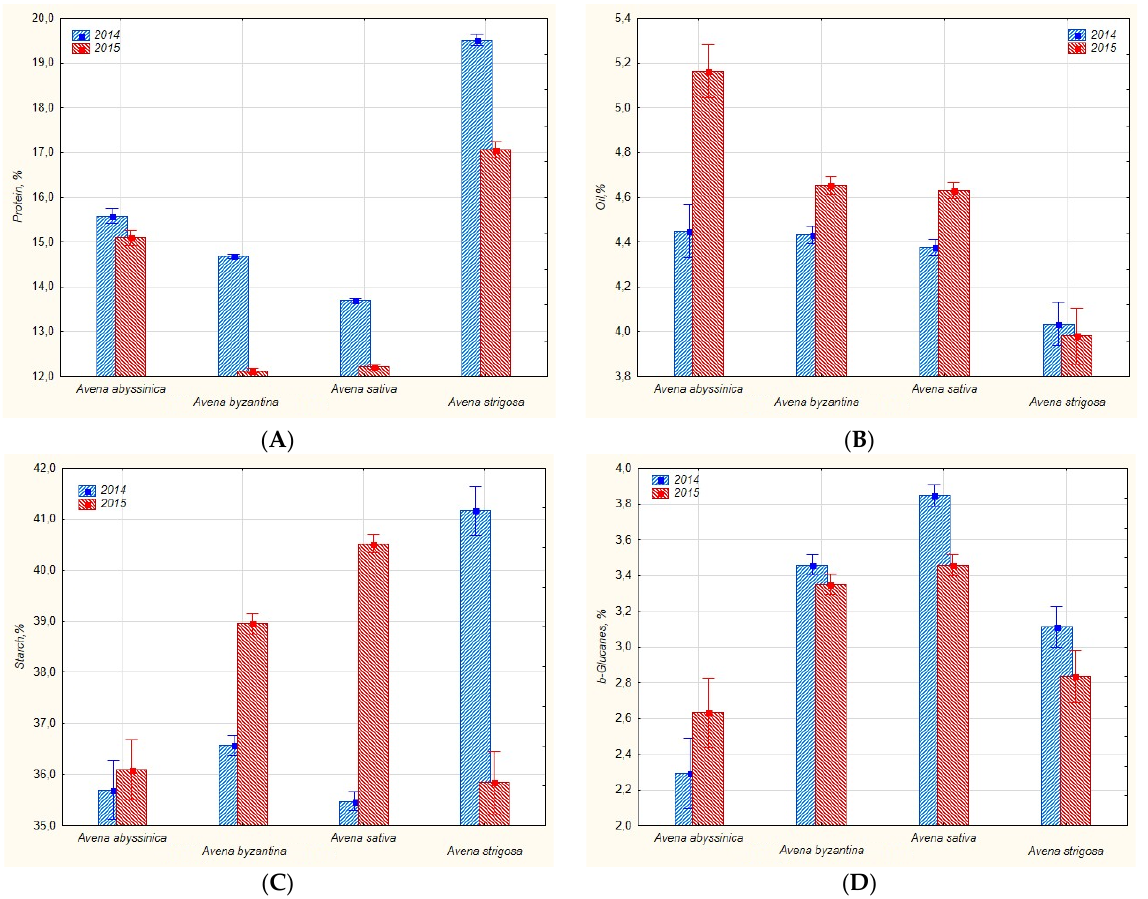
Figure 1. Protein ( A ), oil ( B ), starch ( C ) and β ‐ glucan ( D ) content in Avena L. grain accessions from the VIR collection in 2014–2015.